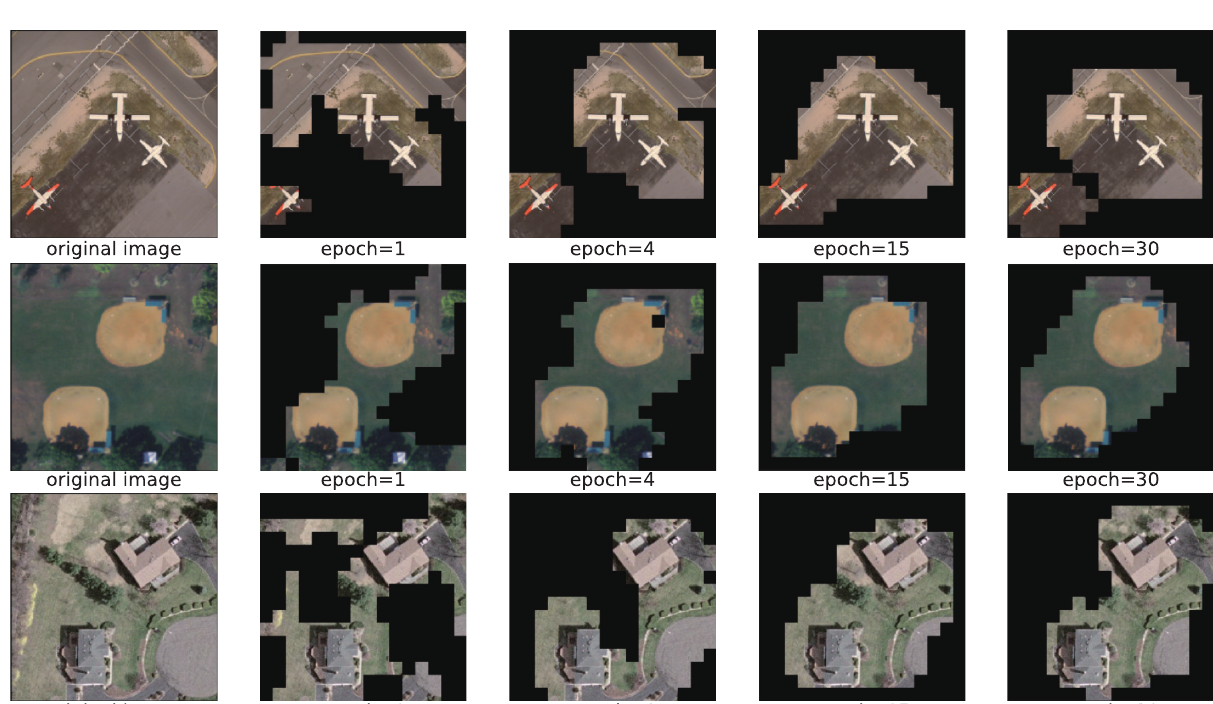
Figure 15. Example of 50% background masking on the UCM